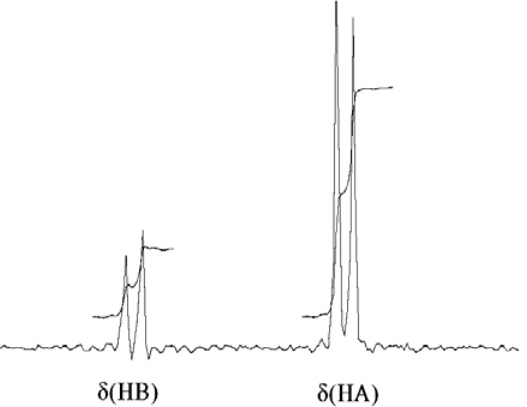
Figure 2. Slice of 1 Н -NMR NOESY spectrum for compound 3b . More intense NOE is registered between NH and H , showing preferable orientation toward the NH. A